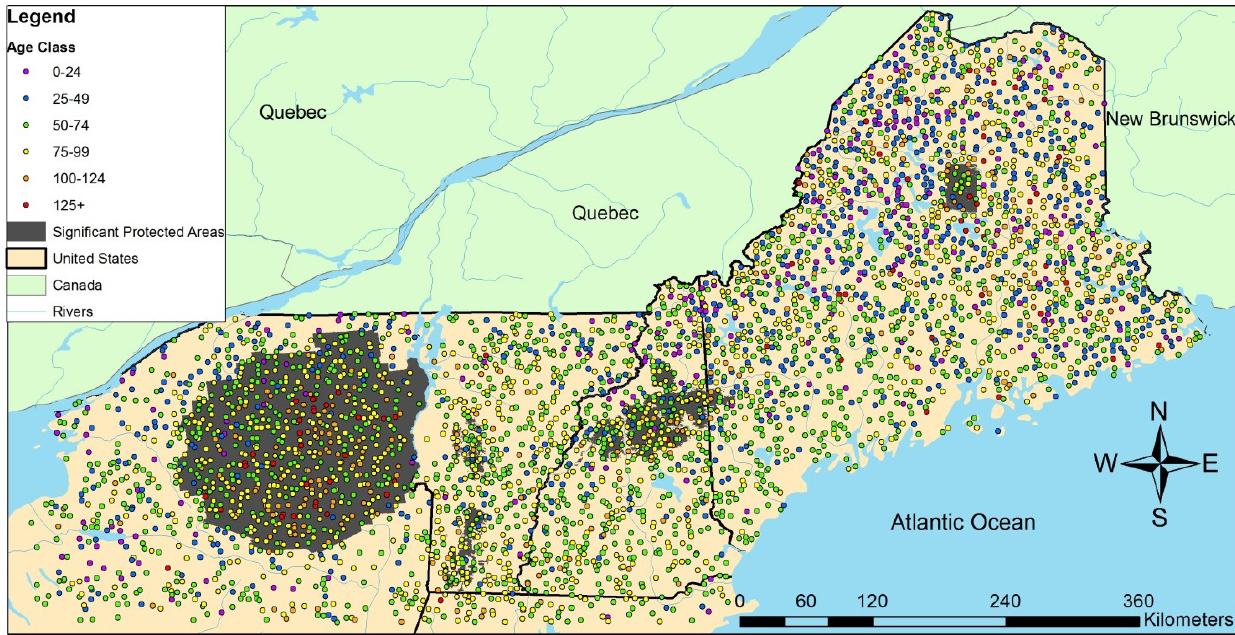
Figure 6. Spatial distribution of FIA plots by age class within the study